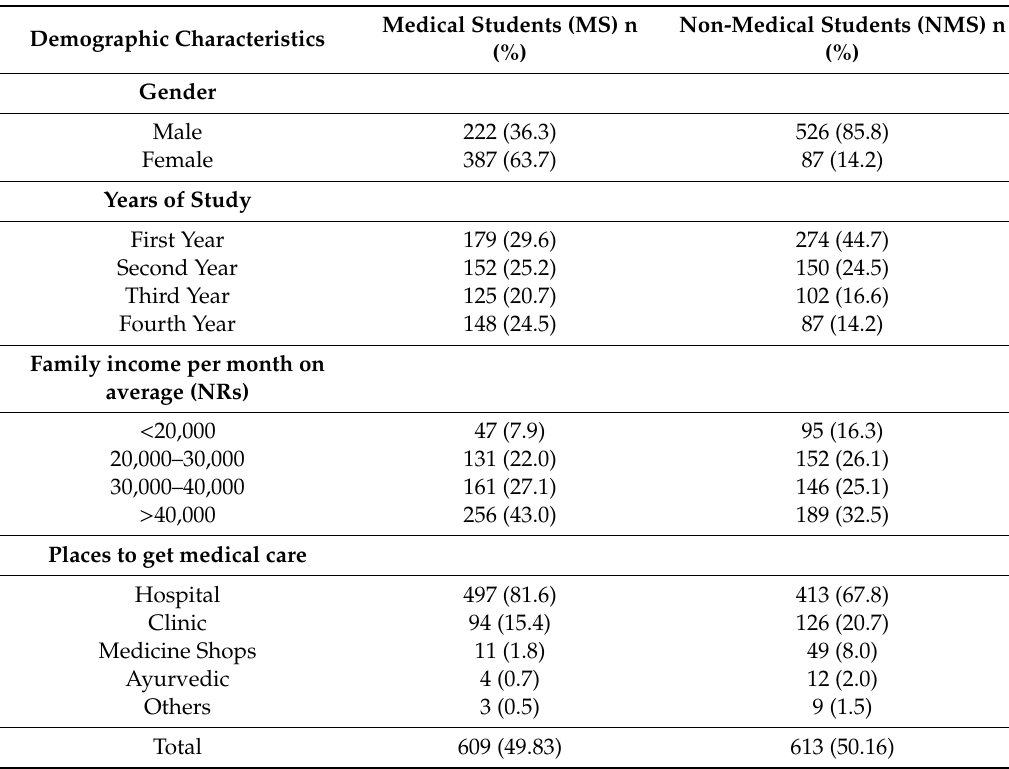
Table 1. Characteristics of 1222